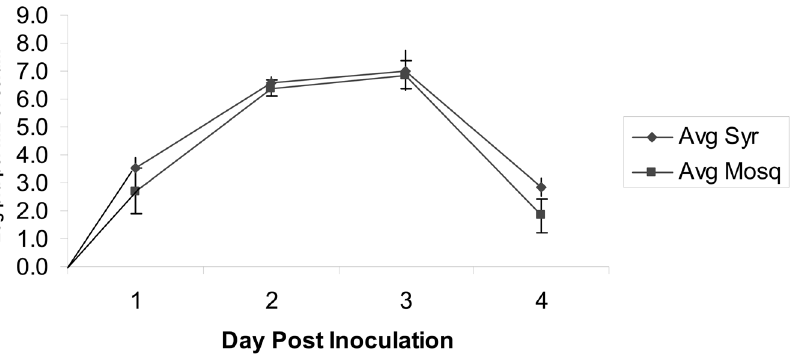
Figure 3. Mean daily titers ( + / 2 SE) of WNV in house sparrows determined by syringe-drawn blood or individual mosquito blood meals.